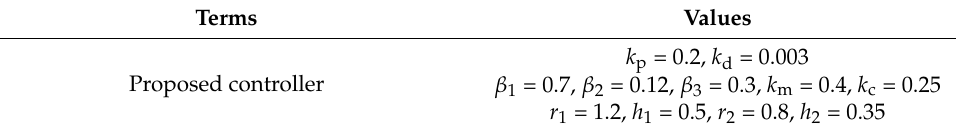
Figure 12. Experiments on the high-precision turntable. Table 7. Parameter settings of the proposed scheme.